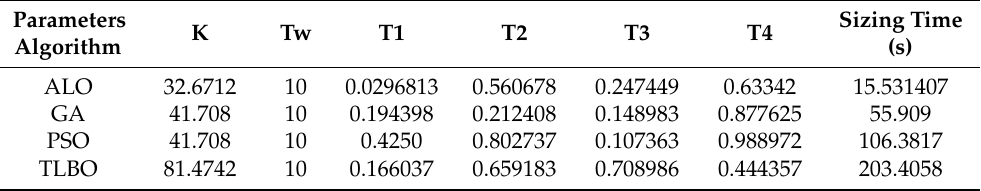
Table 5. Comparison of simulation results of different algorithms.